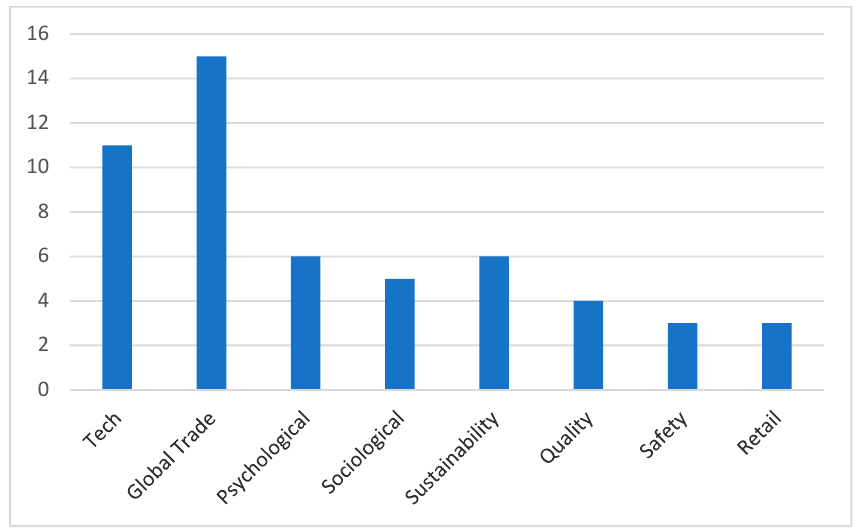
Figure 2. 2020 Research Subjects and Article Quantity.